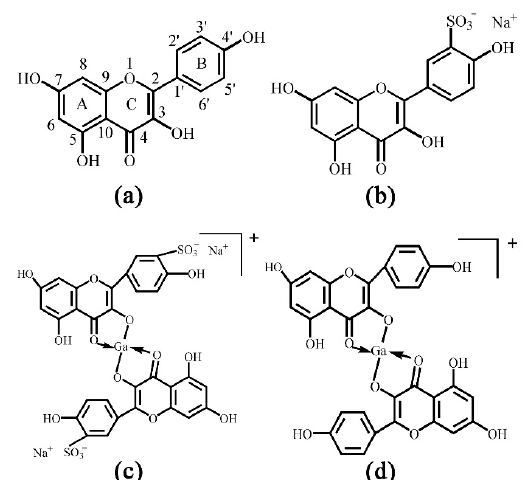
Figure 1. Chemical structures of ( a ) kaempferol (Kae): yellow powder, M r 286.23, ( b ) sulfonated Kae (Kae-SO 3 ): light yellow snowflake solid, M r 365.29, ( c ) gallium (Ga(III)) complex with Kae-SO 3 (Kae-SO 3 -Ga): brownish solid, M r 798.28 and ( d ) Ga(III) complex with Kae (Kae-Ga): dark brown solid, M r 640.17. The relative molecular weight without consideration of counter ions.